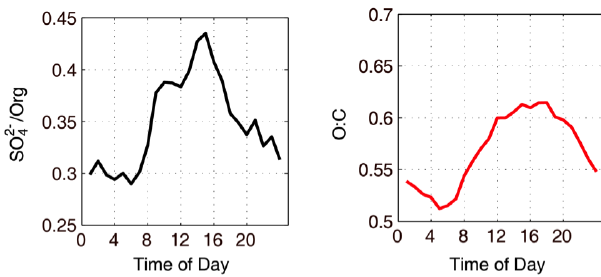
/ Org, O : C of non-size segre- 4